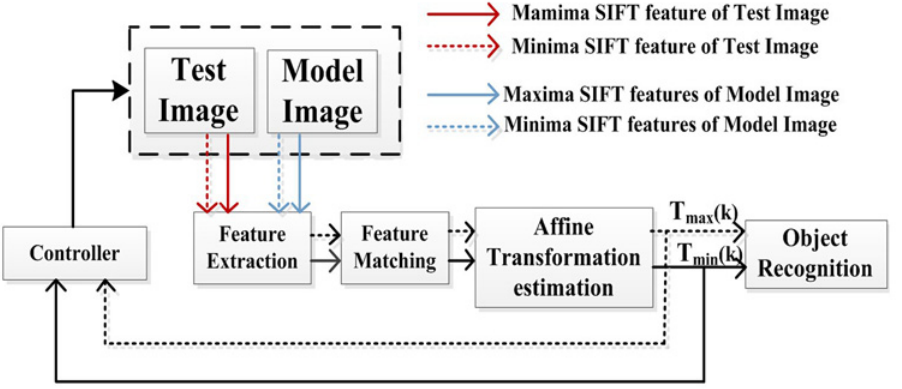
Fig 6. Proposed fuzzy closed-loop object recognition